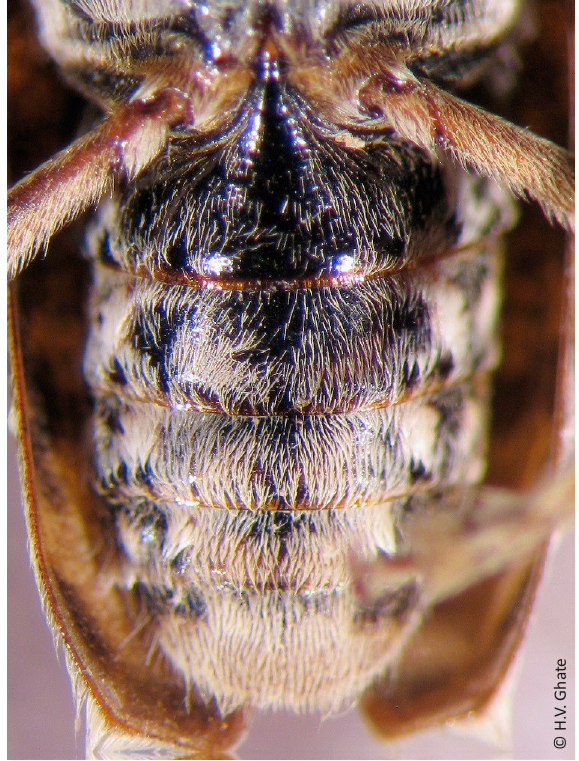
Image 14. Ventral view of abdomen of Apiocephalus , note